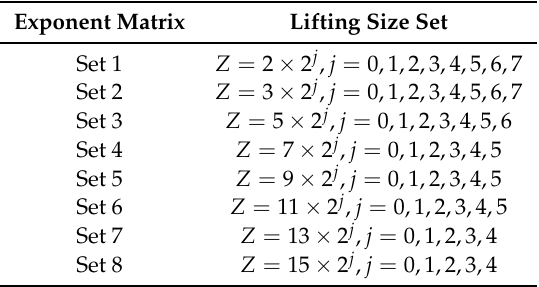
Table 1. Relationship between exponent matrices and sets of lifting